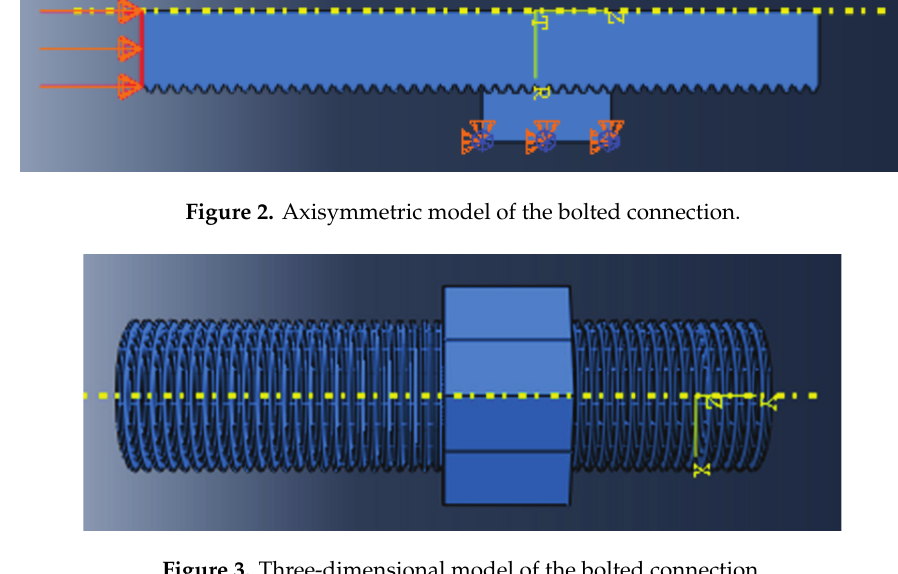
Figure 3. Three-dimensional model of the bolted connection .